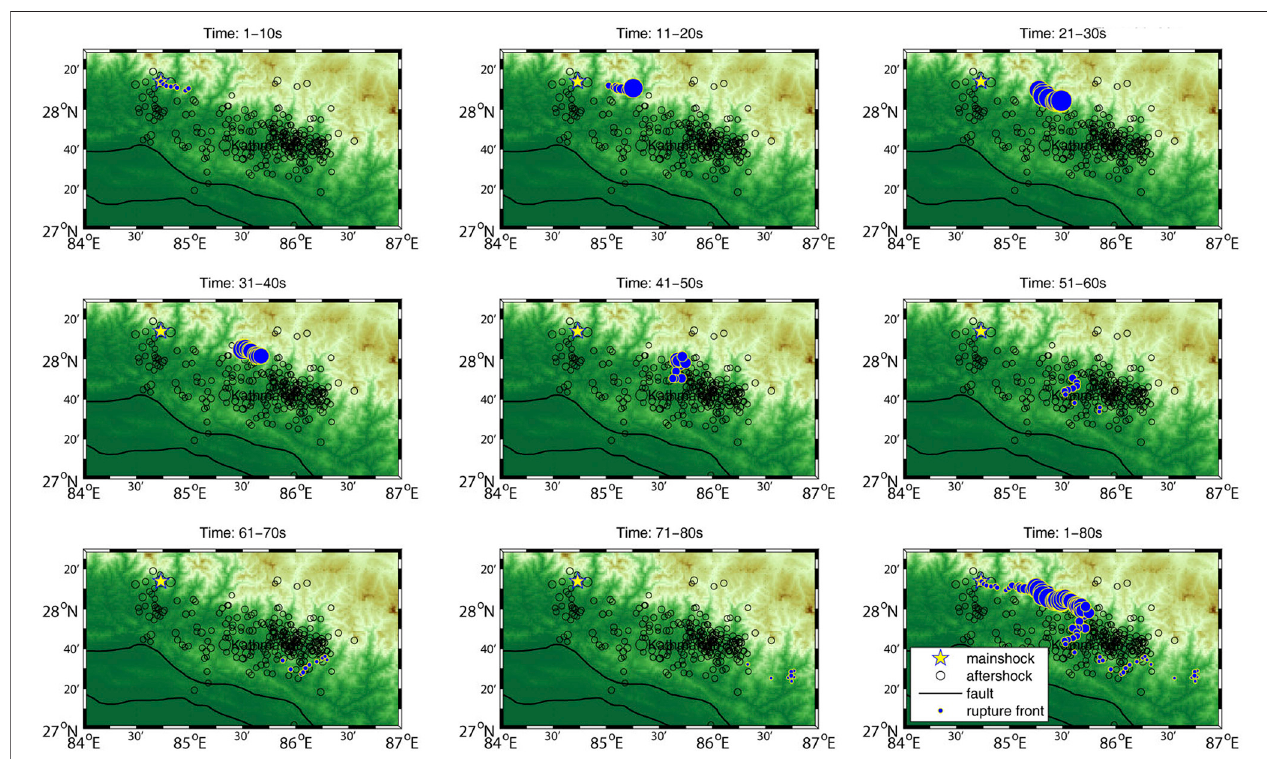
FIGURE7| Snapshotoftherupturefrontofthe2005Nepal – GorkhaearthquakeandthedistributionofallrupturefrontstakenbyMCBP.Theblackcirclesshowthe distribution of aftershocks. The two fault lines from top to bottom are the MBT and the MFT.